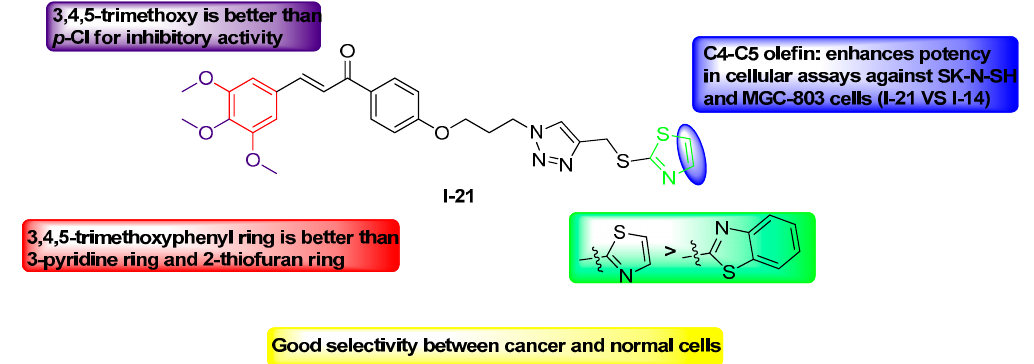
Figure 4. Summary of SAR of chalcone-1,2,3-triazole-azole derivatives.